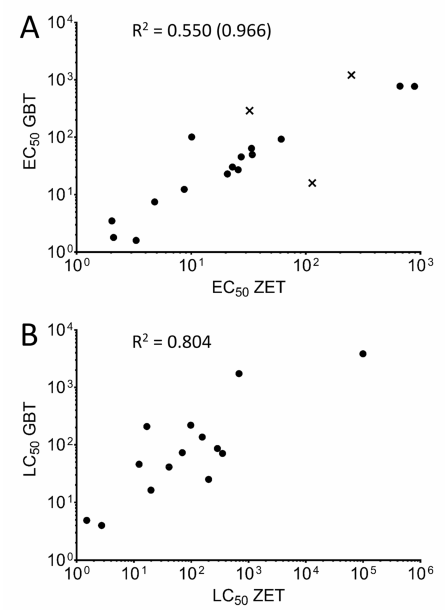
Figure 1. Correlation analysis between assays. The correlation between EC 50 ( A ) and LC 50 ( B ) values was determined between the ZET assay (x-axis) and GBT assay (y-axis). Both axes are displayed as log (values) in for ease of visualization. Compounds with no determined toxicity values for one (Benzophenone, Permethrin, and Thiobendazole) or both (Dechlorane Plus, Amoxicillin) of the assays were omitted from the corresponding analyses. Correlation coe ffi cients (R 2 ) for both correlation analyses are indicated. Removal of the outlying chemicals (Benzophenone, Valproic acid, and Thiobendazole) from the EC 50 analysis whose points on the graph are outside the 95% confidence interval of the linear regression (denoted by “ × ”) results in the correlation coe ffi cient in